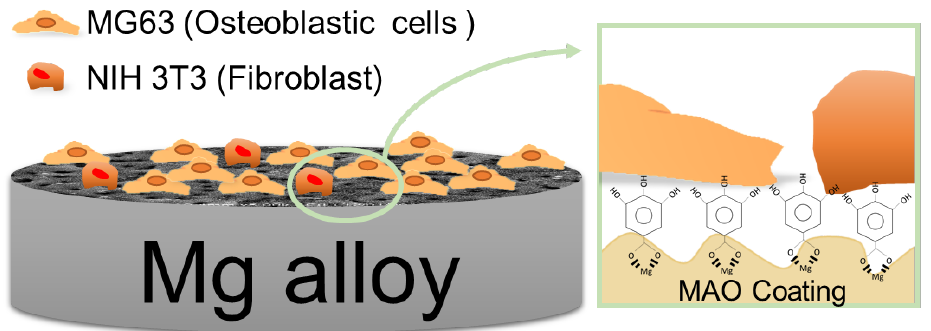
Figure 9. Schematic diagram of the MAO coating modified by gallic acid.